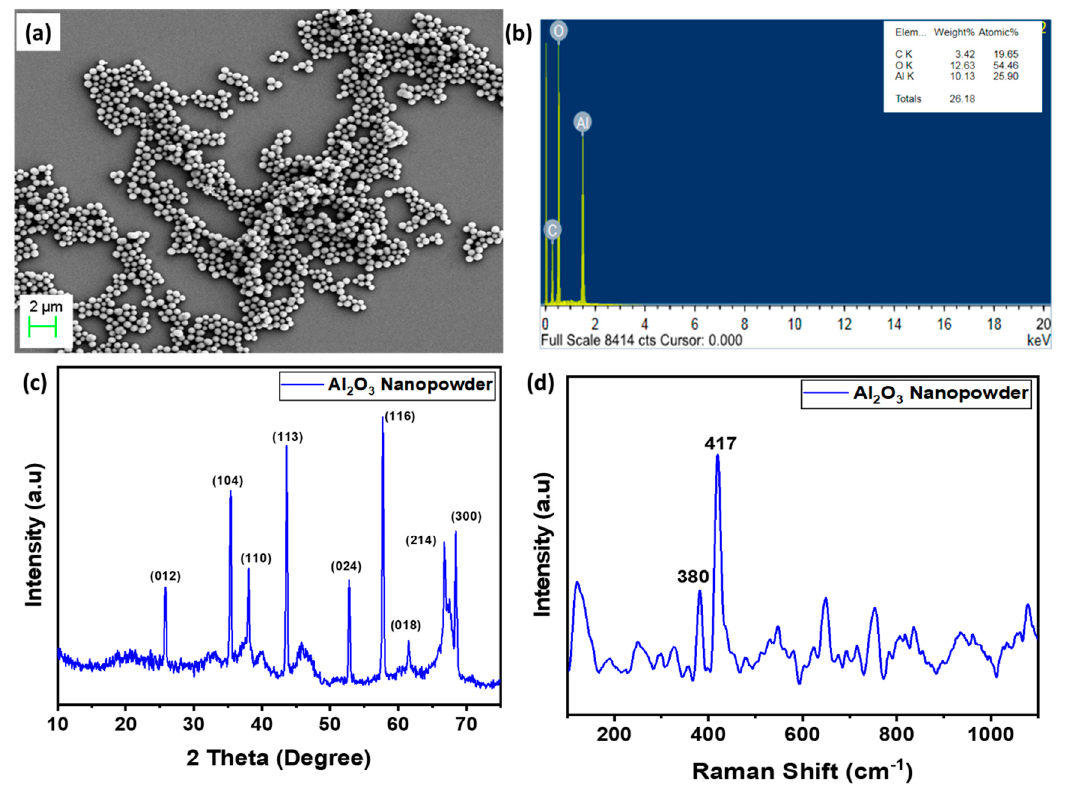
Figure 2. Morphological and structural analysis of as prepared α -phase Al 2 O 3: ( a ) FE-SEM, ( b ) EDX, ( c ) X-ray diffraction spectra, and ( d ) Raman Profile.